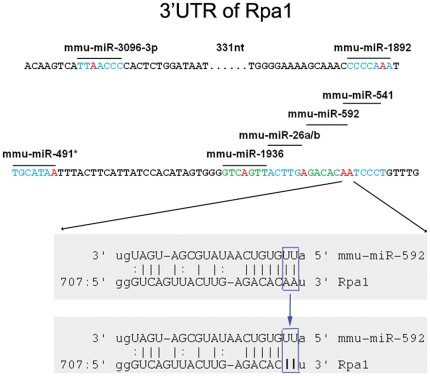
Example of RNA editing at microRNA target sites.One hundred nucleotides of the 3′UTR of Rpa1 is shown. Multiple microRNA target sites form a dense cluster in this region and contain many A-to-I editing sites. Red bases represent RNA editing sites, and blue and green bases represent different microRNA seed locations.